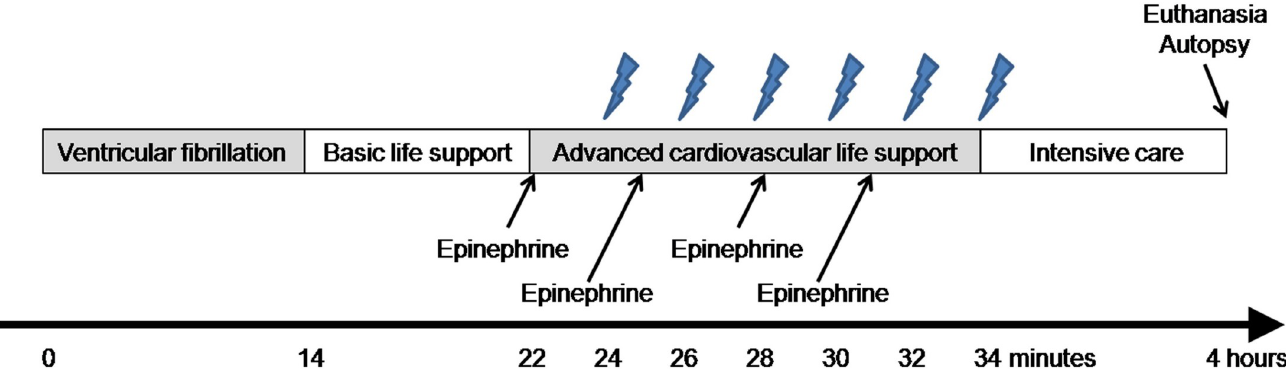
Fig 1. Experimental timeline. Lightning marks indicate the onset of a 10-second pause in chest compressions for rhythm analysis and a 150-J shock, if indicated.